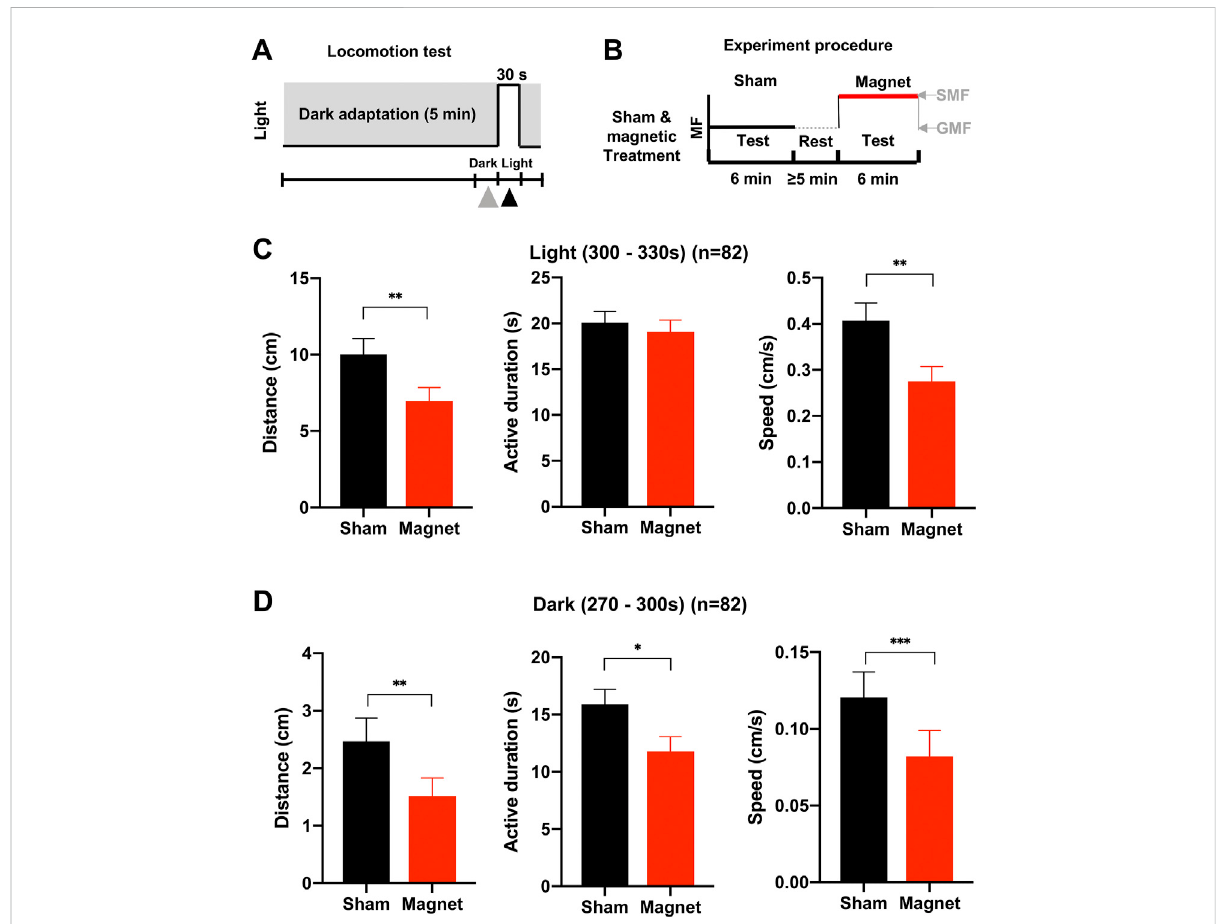
FIGURE 3 The effect of the SMF on the swimming behavior of tadpoles differs between light and dark conditions. (A) The light stimulation mode for the behavioraltest.Thetrianglesrepresentthelast30softhedarkadaptationperiod(270 – 300 s)andthe fi rstlightpulse(the30 slightstimulationperiod (300 – 330 s),respectively,fordataanalysis. (B) Theexperimentalprocedureforsequentialtestsundershamandmagneticconditions.Thehorizontal axisrepresentstest/resttime.Theverticalaxisrepresentstherelativemagnetic fi eldstrengthofdifferenttreatmentconditions.Theblackdotted line represents the relative magnetic fi eld strength without a nickel/magnet during the test. The black and red lines represent the relative magnetic fi eld strength with the presence of a nickel and the magnet during the test, respectively. A “ test ” means acomplete locomotion observation by using the light stimulation mode described in panel (A) (C,D) Effects of the SMF treatment on locomotion indexes of tadpoles in the dark (C) or in the light (D) . SMF inhibits tadpole swimming distance and speed in the light condition, and the swimming distance, active duration, and speed in the dark. n is the total number of tadpoles from seven experiments, twelve tadpoles per experiment. Data are expressed as mean ± SEM. The p values were calculated using the Wilcoxon matched-pairs signed-rank test. * p < 0.05, ** p < 0.01, *** p <